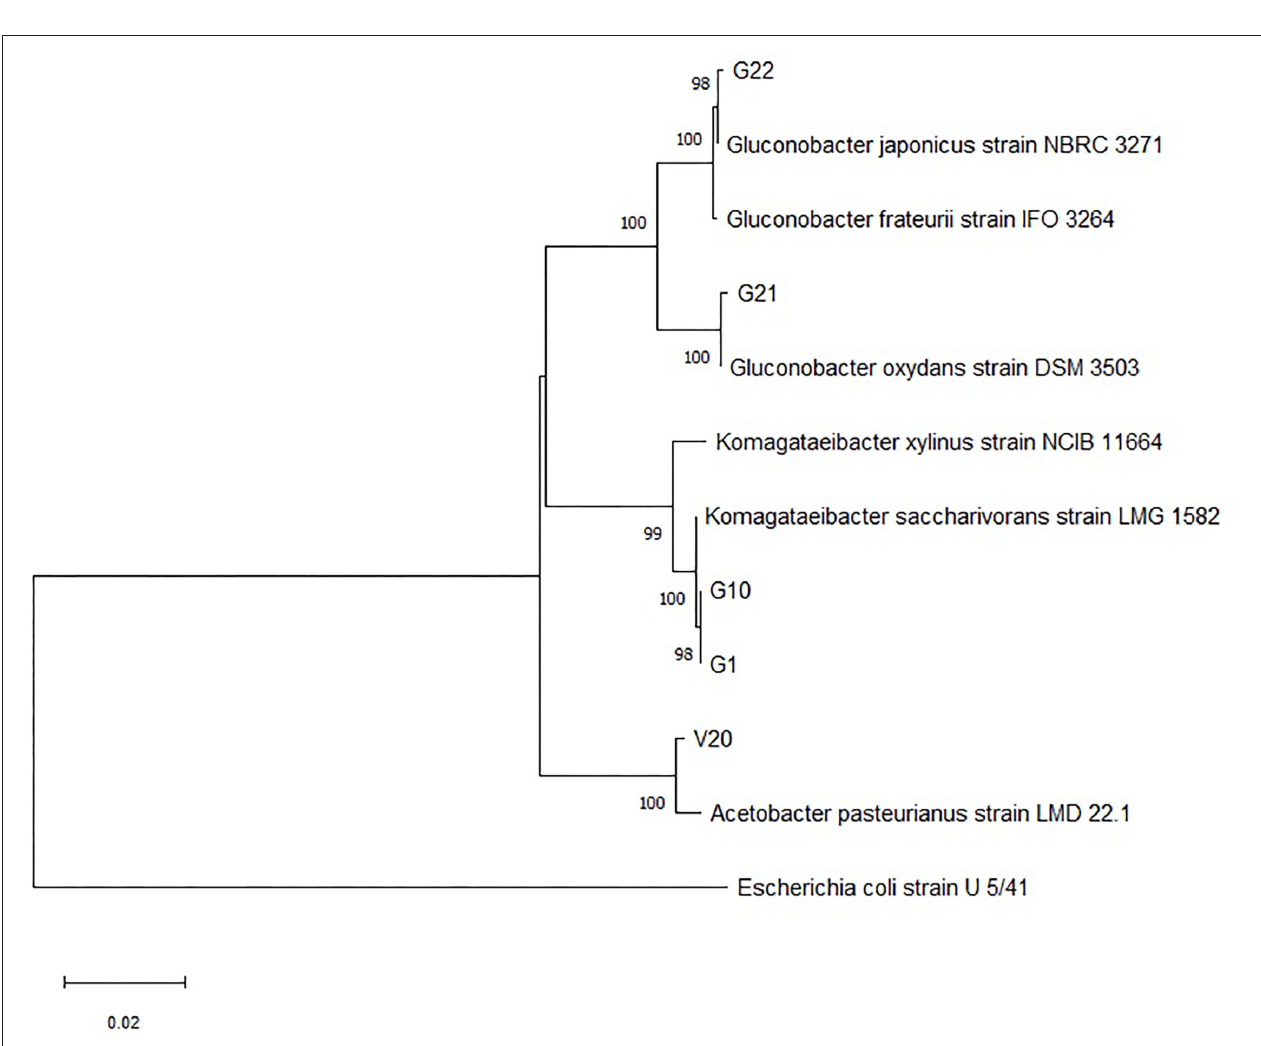
FIGURE 2 | Phylogenetic tree showing the location of the selected strains based on 16S rDNA gene sequences, using the neighbor-joining (NJ) algorithm and Mega version 5.0. The tree was rooted using sequences of Acetobacteraceae present in the NCBI database, and Escherichia coli U5/41 was used as an outgroup. Bar scale indicates phylogenetic distance. The numbers at the branches represent bootstrap values (100 bootstrap re-sampling).